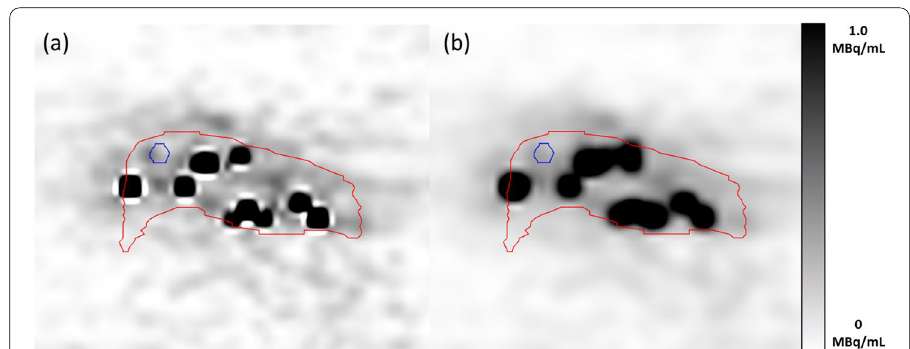
Fig. 7 Sagittal slices of the PET-based activity distribution A PET a before filtering with a 4 mm FWHM Gaussian kernel, and b after filtering with a 4 mm FWHM Gaussian kernel. The red contour represents the liver volume L and the blue contour represents the circular ROI where the standard deviation of 90 Y activity concentration values was measured. The concentration values are displayed with a range of 0–1.0